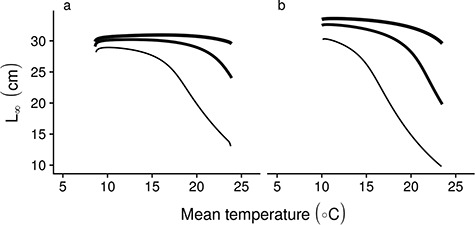
Interactive effects of food availability and temperature of the asymptotic size (\documentclass[12pt]{minimal}
\usepackage{amsmath}
\usepackage{wasysym}
\usepackage{amsfonts}
\usepackage{amssymb}
\usepackage{amsbsy}
\usepackage{upgreek}
\usepackage{mathrsfs}
\setlength{\oddsidemargin}{-69pt}
\begin{document}
}{}${L}_{\infty }$\end{document}), with increasing line width showing increasing food resource availability for (a) slow and (b) fast life-history species.